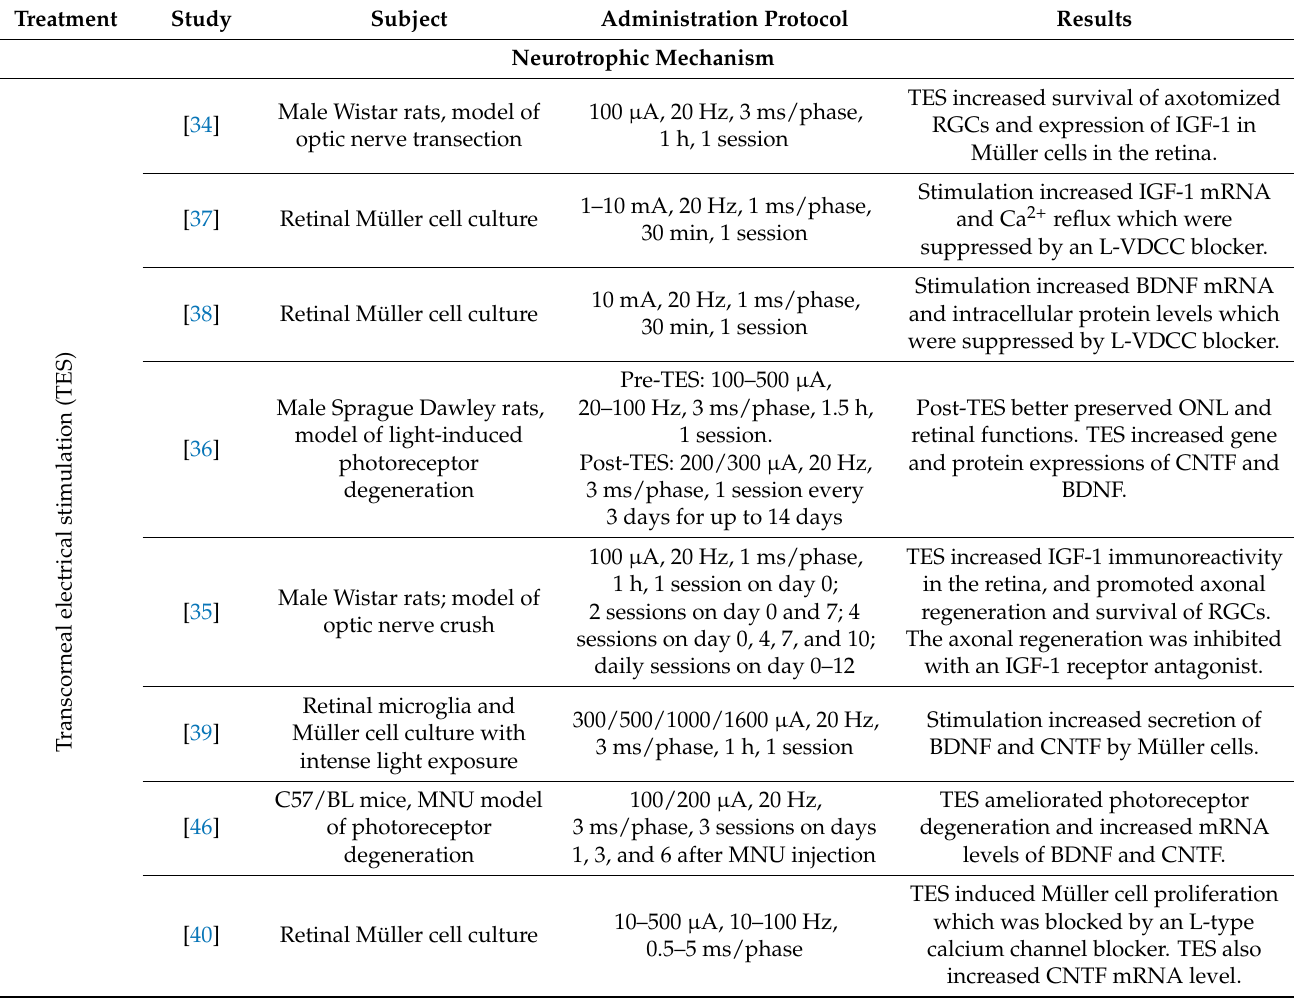
Table 1. The shared mechanisms of action of TES for visual improvement and FDA-approved treatments for depression. The associated biomarkers and/or behavioural changes of TES-induced neurotrophic, anti-apoptotic, and anti-inflammatory mechanisms in preclinical ophthalmology studies are compared with those of FDA-approved treatments for depression, namely, the SSRIs, rTMS, and